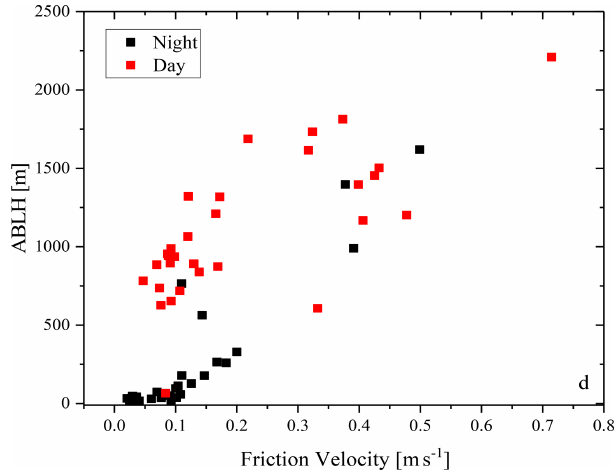
Figure 6. Scatter plot of ABLH vs. friction velocity for the month of October 2012. Results are reported for both daytime (red dots, 12:00UTC) and night-time (black dots,